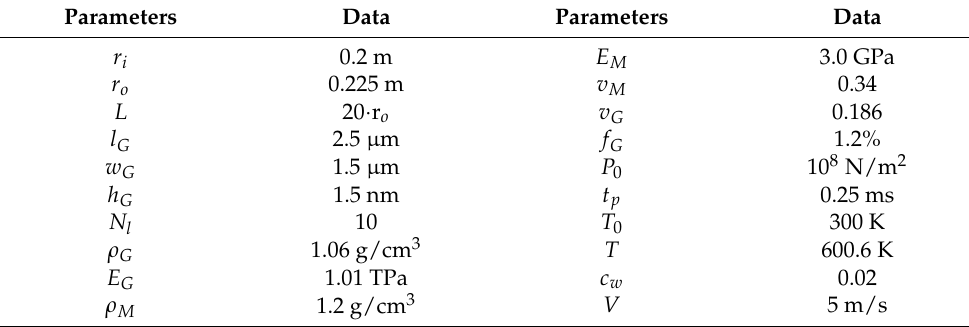
Table 1. Material parameters and geometric parameters of